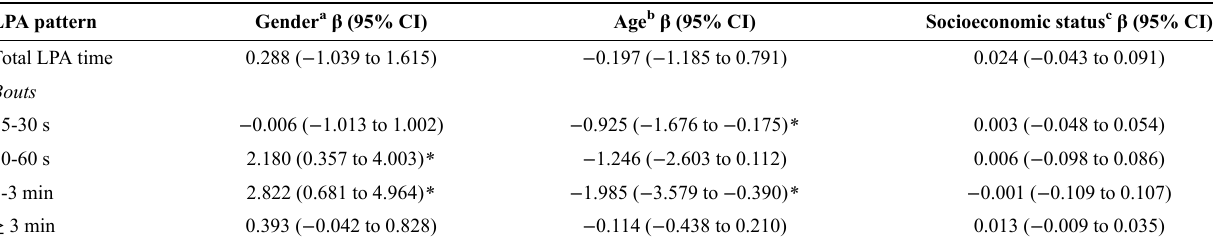
Table 2 - Association between light physical activity patterns and gender, age, and socioeconomic status from